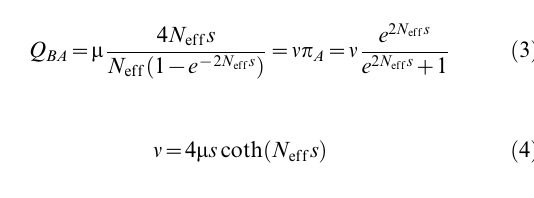
November 2009 | Volume 5 | Issue 11 |